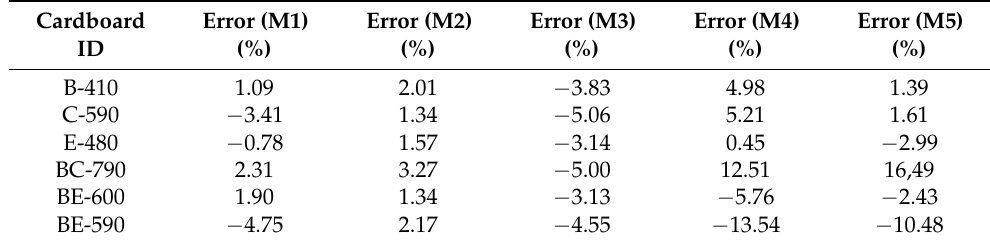
Table 7. Estimation error obtained using five different models.